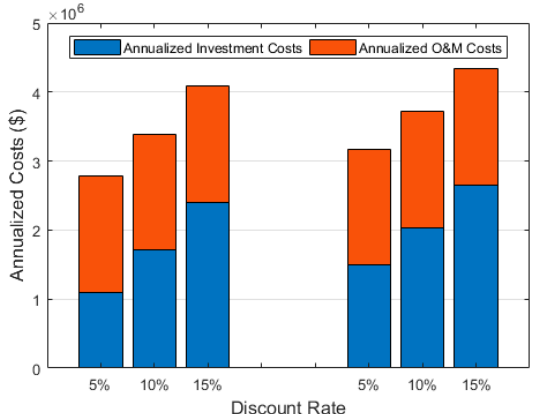
Figure 6. The annualized cost of a logistics system that is composed of 10 ESTs and 140 mobile BESS units. The first group ( left ) considers 25 years as the lifetime of the ESTs and BESS units, while the second group ( right ) considers 15 years.